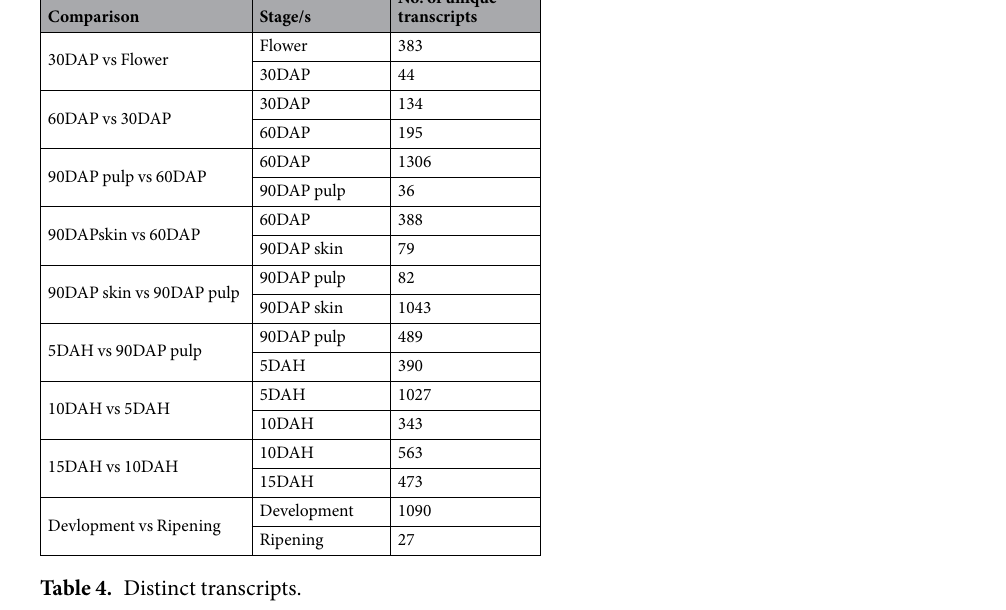
various transcription and translation factors, late embryogenesis abundant proteins, stress-sensitive and dehydration-responsive element-binding protein-1b and various ribosomal proteins. Similarly, distinct transcripts specific to fruit developing and ripening stages were identified, wherein 1,090 and 27 transcripts were idiosyncratic to the fruit developing and ripening stages, respectively (Supplementary Table ST2). Various auxin and gibberellin induced and regulated proteins as well as several proteins responsible for various vacuole activities, multiple disease resistance proteins and various terpene synthases were distinct to the developing stages. Transcripts encoding for multiple transcription and translation factors during Alphonso fruit development were also detected. Interestingly multiple ethylene responsive transcription factors along with the protein reversion-to-ethylene sensitivity were uniquely revealed in the developing stages. Whereas, NIN-like protein, respiratory burst oxidase homolog protein d-like, rhamnogalacturonate lyase b-like, lectin receptor kinase, gag protein and methionine Υ -lyase were exclusive to the Alphonso ripening stages. Similarly, WRKY transcription factor 43, b3 domain-containing val3 and ap2 ERF domain-containing transcription factors were uniquely identified from the ripening stages. Several hypothetical and uncharacterized proteins were also found to be Alphonso ripening specific and their characterization might help to reveal the ripening process in Alphonso. Gene ontology (GO) enrichment. Fisher’s exact test was performed to understand over- and down-represented GOs (p-value ≤ 0.001) during the transition, which gave an overall picture of the Alphonso mango develop- ment and ripening (Fig. 3). During the flower to 30 DAP fruit transition certain GOs were over-expressed such as post-embryonic developmental and anatomical structure morphogenesis process, response to abiotic stimulus and various plastid and thylakoid processes. At the same time, hydrolysis of O- glycosyl compounds and UDP-glycosyltransferase activity along with the methyltransferase, sucrose metabolic and lipid biosyn- thetic activities coding GOs were down-represented. 30 DAP to 60 DAP transition described enriched GOs for starch and sucrose metabolic process, fatty acid, cellulose and vitamin biosynthetic processes, protein glycosyl- ation, response to oxidative stress and heat along with HSP binding. During the same event cell differentiation, growth and cell death in addition to the anatomical structure morphogenesis, secondary metabolic process and response to biotic stimulus coding GOs were observed to be decreased. Comparison between 60 DAP fruit and 90 DAP pulp revealed over-represented GOs for cell differentiation and cell growth, response to biotic stimu- lus, secondary metabolic process, tropism and regulation of gene expression. While, starch and sucrose meta- bolic processes, O- glycosyl hydrolase UDP-glucosyltransferase activities, fatty acid biosynthesis and catabolic processes along with the lipid transport, various amino acid and terpenoid biosynthesis and cell wall biogen- esis were down-represented. 90 DAP pulp and skin tissues showed over-expression of various ion, ADP and sequence-specific DNA binding activities along with the response to hormone, chemical and organic substances in the skin tissue; whereas only cytoplasm and cytoplasmic part related GOs were found to be down-expressed in the skin compared to that in the pulp at 90 DAP. Transition of 90 DAP pulp to 5 DAH pulp revealed only over-representation of GOs such as biosynthesis of RNA, aromatic compounds, and nucleobase containing compounds; binding of various ions; regulation of primary, cellular, nitrogenous compounds, RNA biosynthesis processes and gene expression and response to hormone, chemical and organic substance. Surprisingly, none of the GOs showed significant (P-value ≤ 0.001) enrichment during the transition from 5 DAH to 10 DAH and reflected as the stationary phase of Alphonso mango ripening. The 10 DAH (mid ripe stage) to 15 DAH (ripe stage) transition showed over-expression of many GOs such as binding of various ions; phospholipid, glycolipid, amino acid, co-enzyme and water soluble vitamin